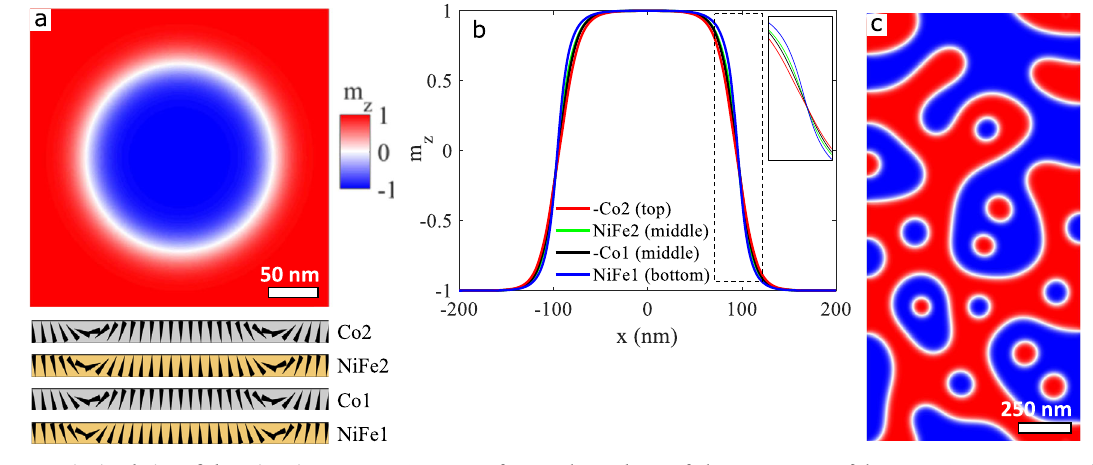
Fig. 2 | Micromagnetic simulation of skyrmions in a SAF. a Spin texture of a skyrmionintheCo1layerandacrosstheskyrmiondiameterwithinthedifferentFM